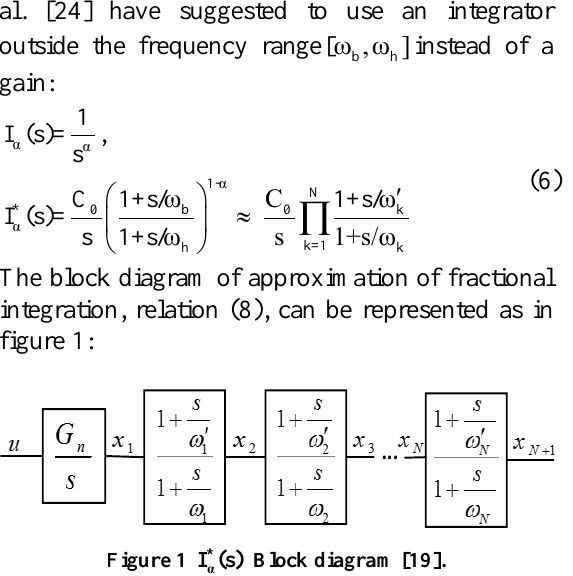
I (s) Block diagram [19]. Figure 1 * α